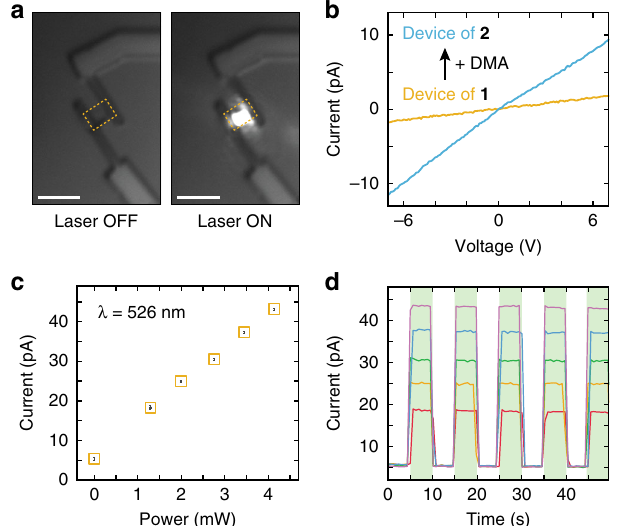
Fig. 4 Stimuli responsive conductivity of Mo 2 (INA) 4 single-crystal devices. a Optical images collected during measurement of a device fabricated on a single crystal of 1 . The crystal boundary is highlighted by the dashed gold box and the bright diffraction-limited laser spot is evident in the right image. Scale: 5 µ m. b Current – voltage characteristics of a single- crystal device of 1 (yellow) and of a single-crystal device of 2 (blue) prepared through exposure to DMA. c Photocurrent generated by a single- crystal device of 1 when illuminated with a 526 nm laser at 1.29, 1.99, 2.76, 3.45, and 4.14 mW. The device source-drain bias was held constant at 20 V. Error bars denote standard deviation. d Photocurrent switching behavior of a single-crystal device of 1 subjected to periodic laser illumination at 5-s intervals (green highlighted regions). Device switching behavior was assessed at 1.29 mW (red), 1.99 mW (orange), 2.76 mW (green), 3.45 mW (blue), and 4.14 mW (purple).